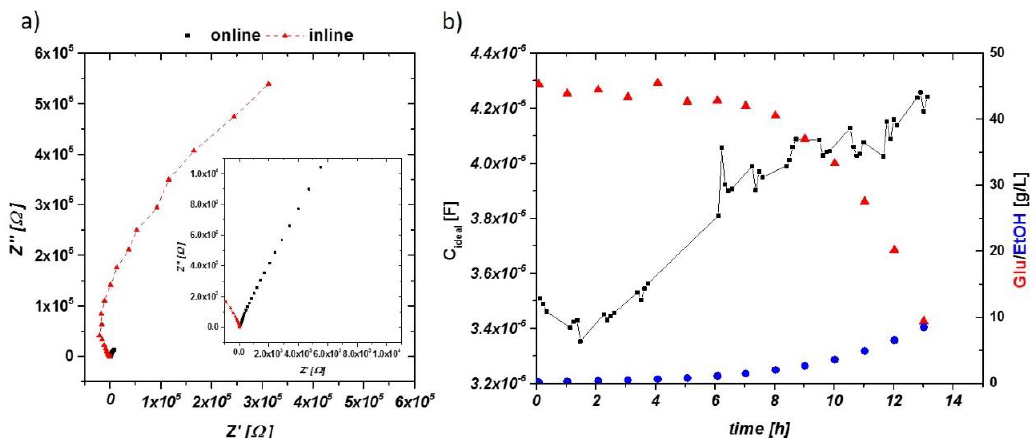
Figure 6. ( a ) Impedance raw data in the Nyquist plot for an aerobic cultivation. Black squares represent the signal from the online probe—enlarged in the inlay—and red triangles, the inline probe at similar time stages. Capacitance of the inline probe is one order of magnitude lower (as a result of smaller electrode areas). ( b ) The dependence of the impedance signal (not smoothed), glucose consumption and ethanol production in an aerobic cultivation using the inline probe.